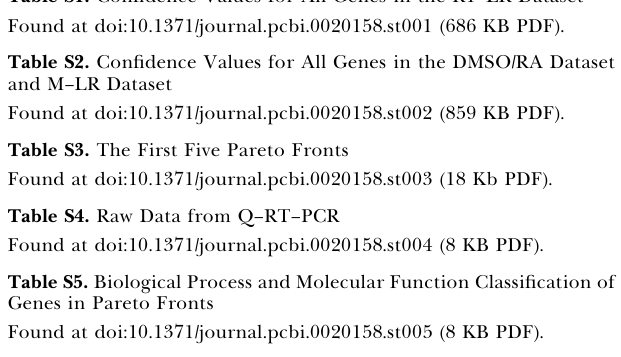
Table S6. Comparison of Table S3 with Other Publications Table S7. Probeset Translations between the MG_U74v2 and MOE430 Genechips Found at doi:10.1371/journal.pcbi.0020158.st007 (365 KB PDF). Table S8. Primers Used for